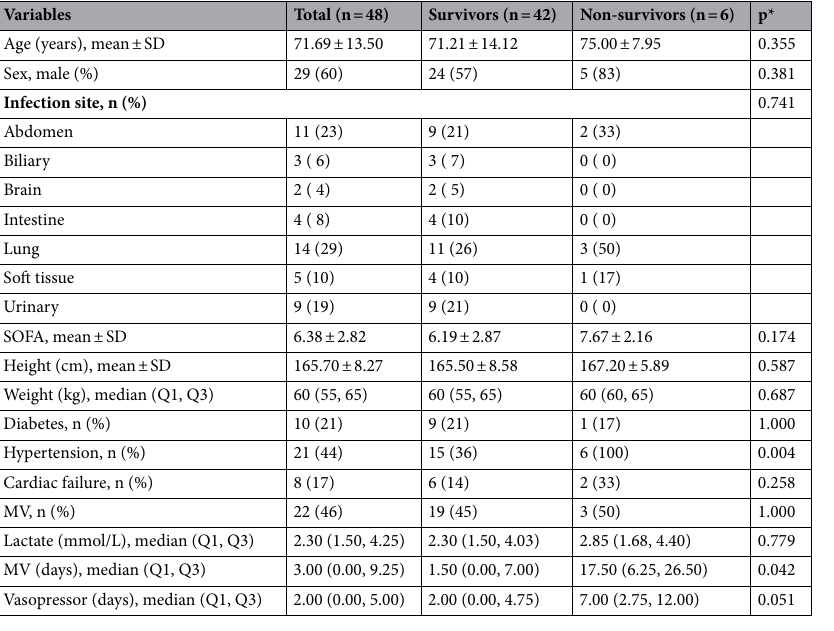
Table 1. Clinical characteristics of the sepsis cohort. SD standard deviation, SOFA sequential organ failure assessment, MV mechanical ventilation, Q1 the first quartile, Q3 the third quartile, CRP C-reactive protein. *p value was reported for the comparison between survivors and